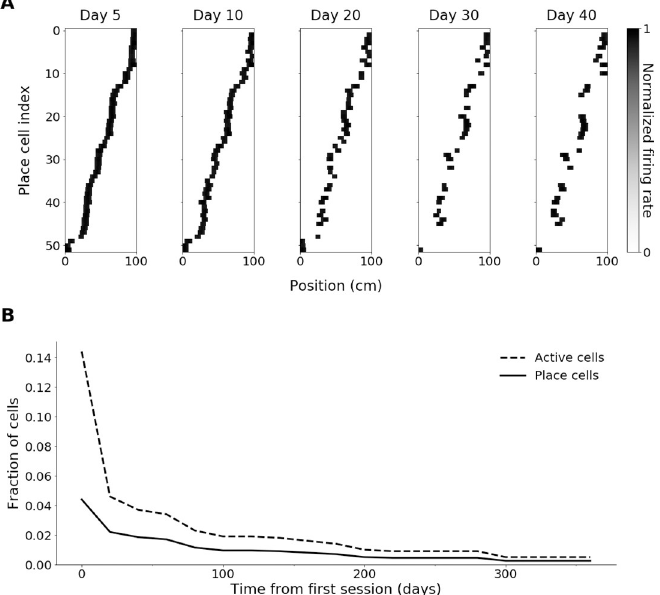
Fig 1. Simulation with long-term stability of place fields without novel place field formation. (A) Place field maps of cells with significant place fields on day 5, for days 5 to 40, indexed according to centroid position along the track on day 5. (B) Proportion of active cells and place cells over 365 days. Simulations were carried out with Hebbian learning. The results of a single run of the simulation of model 1 are shown.